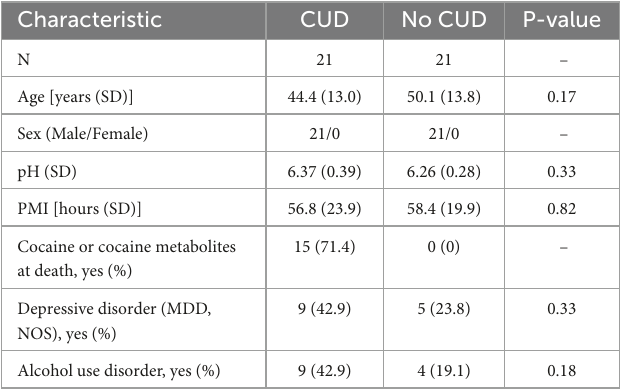
TABLE 1 Demographic data of sample donors included in the present study on cocaine use disorder